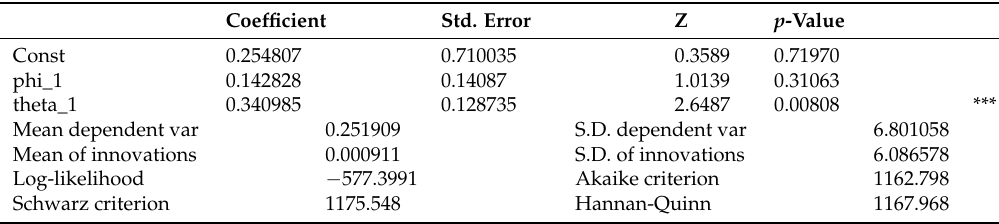
Table 1. Model 1: ARIMA, using observations 1986:2–2017:1 (T = 124) Dependent variable: (1-L) v1—Standard errors based on Hessian.